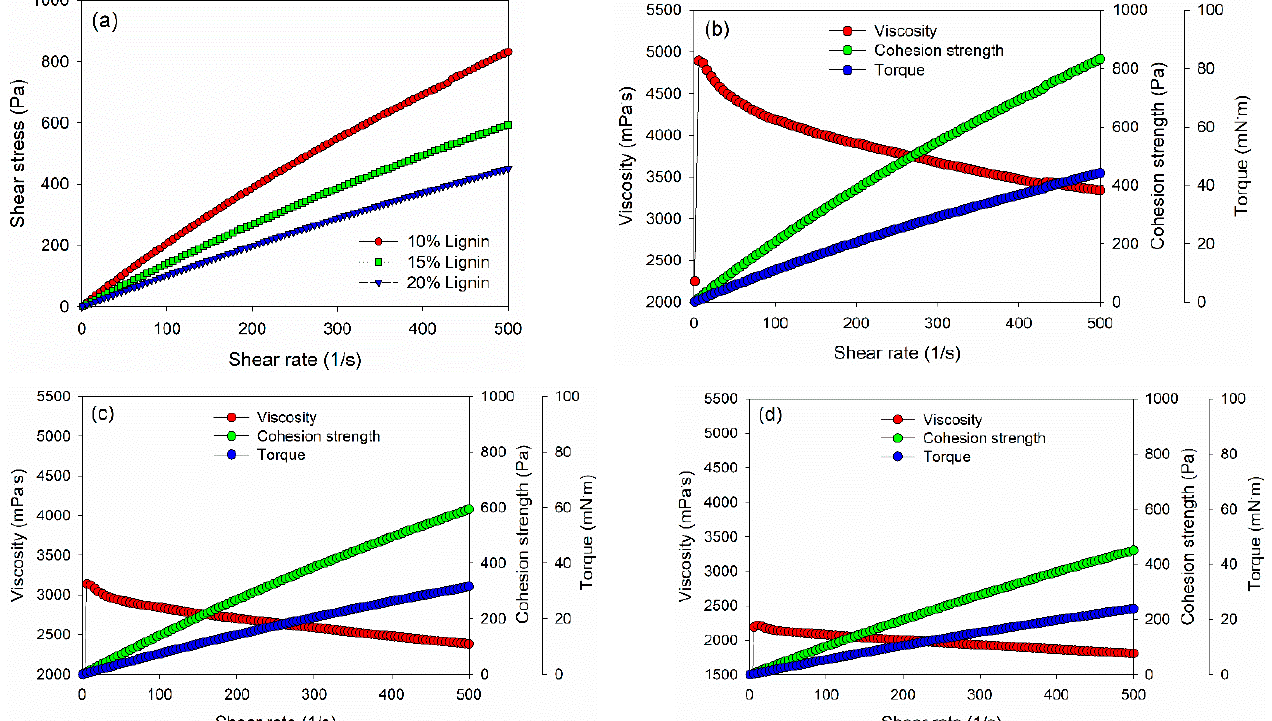
Figure 3. Viscosity, torque, and cohesion strength of PVOH–lignin–hexamine blends with different contents of lignin: ( a ) shear rate–shear stress curve, ( b ) 10% lignin, ( c ) 15% lignin, ( d ) 20% lignin.